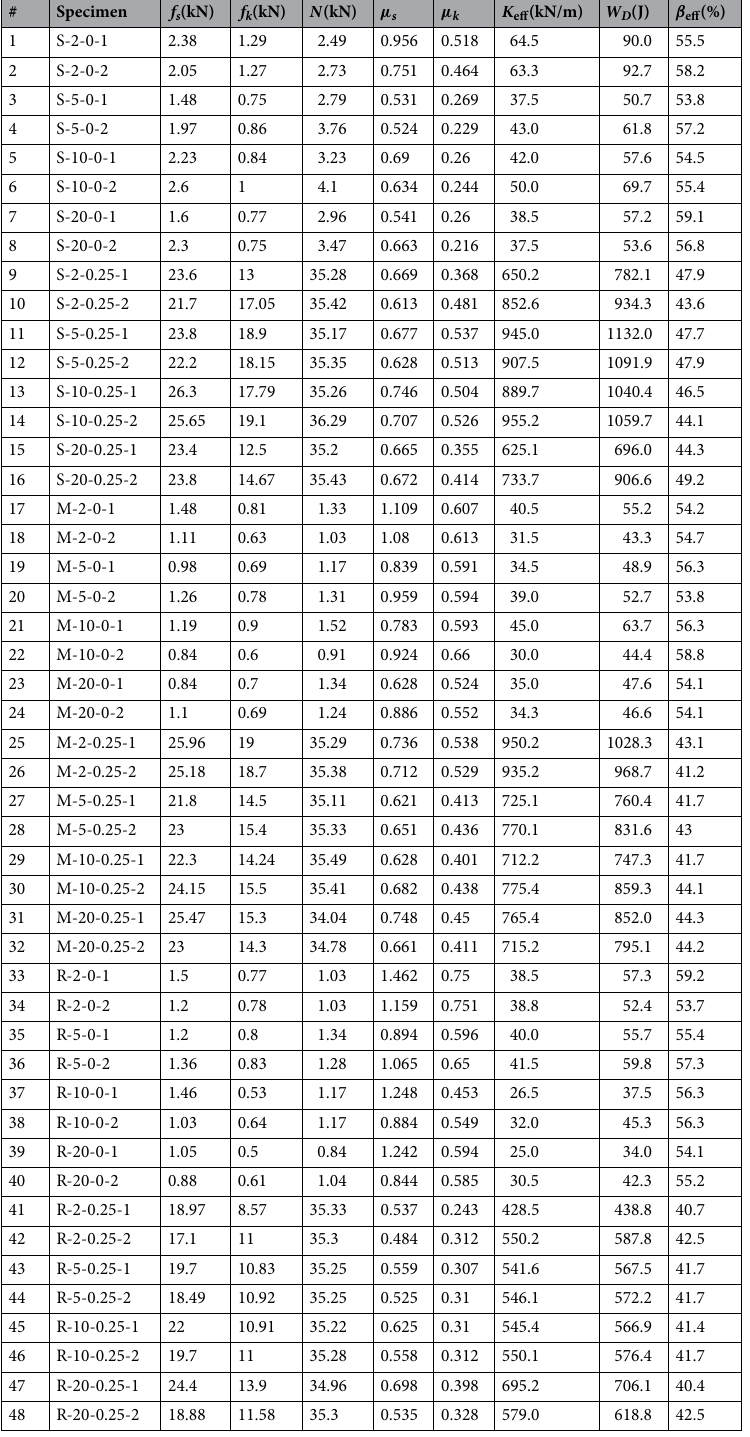
Table 3. Friction, stiffness, and damping